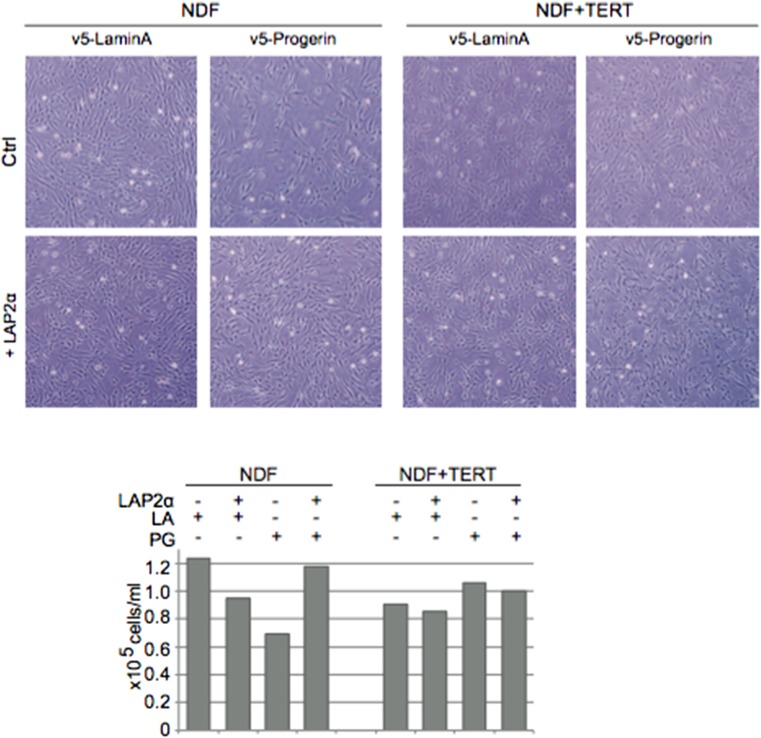
DOI:
http://dx.doi.org/10.7554/eLife.07759.020